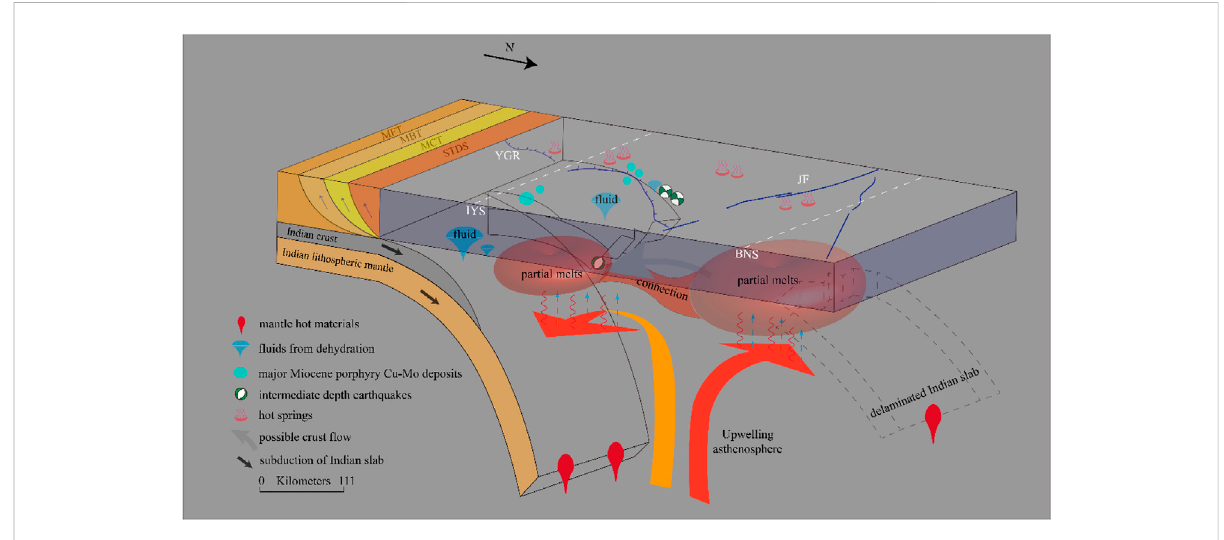
FIGURE 14 3-D interpretative diagram of the current crustal and lithospheric mantle structure beneath YGR, showing the subduction mode of the Indian slab. MFT, Main Frontal Thrust; MBT, Main Boundary Thrust; MCT, Main Central Thrust; STDS, Southern Tibetan detachment system; JF, Jiali